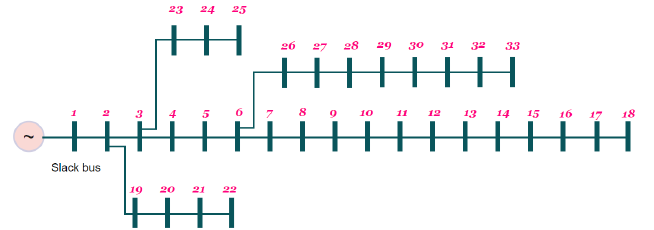
Figure 5. Single line diagram of the 33-bus test distribution